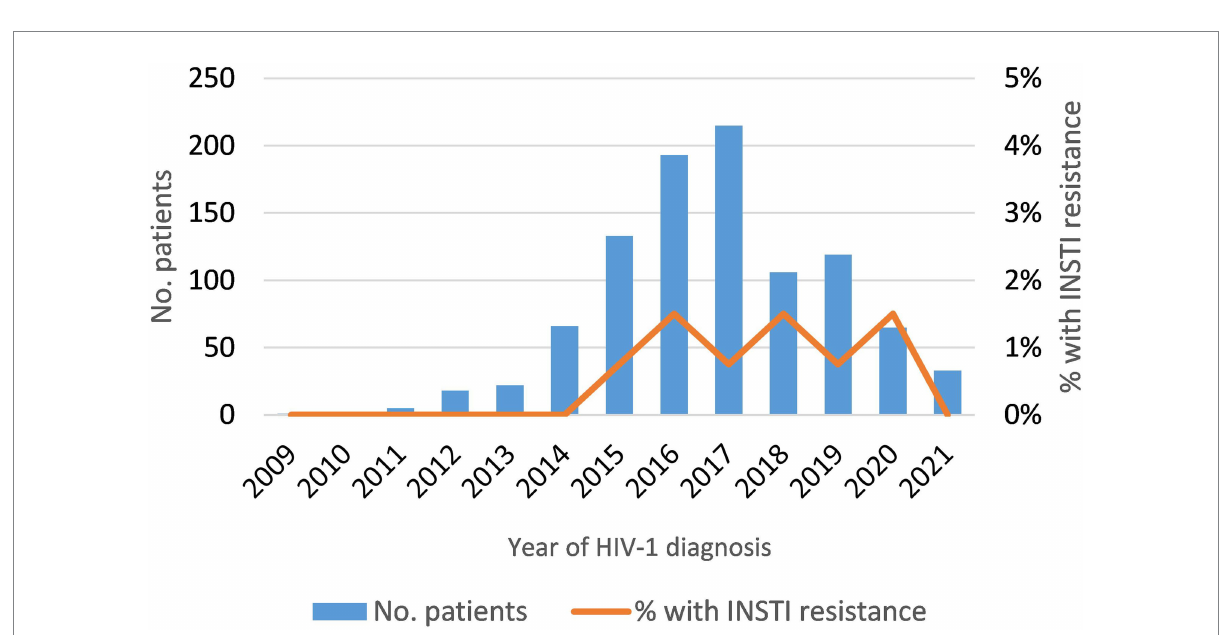
FIGURE 1 Temporal trend of INSTI resistance in newly-diagnosed HIV-1 patients analyzed in this study (2009–2021).